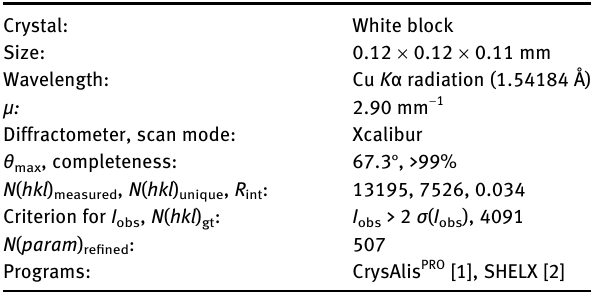
Table 1 contains crystallographic data and Table 2 contains the list of the atoms including atomic coordinates and displacement parameters.